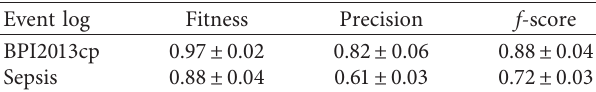
Figure 10: The completeness curves for 10 runs on Sepsis. Table 8: The alignment-based fitness and precision of the DEMiner on two real event